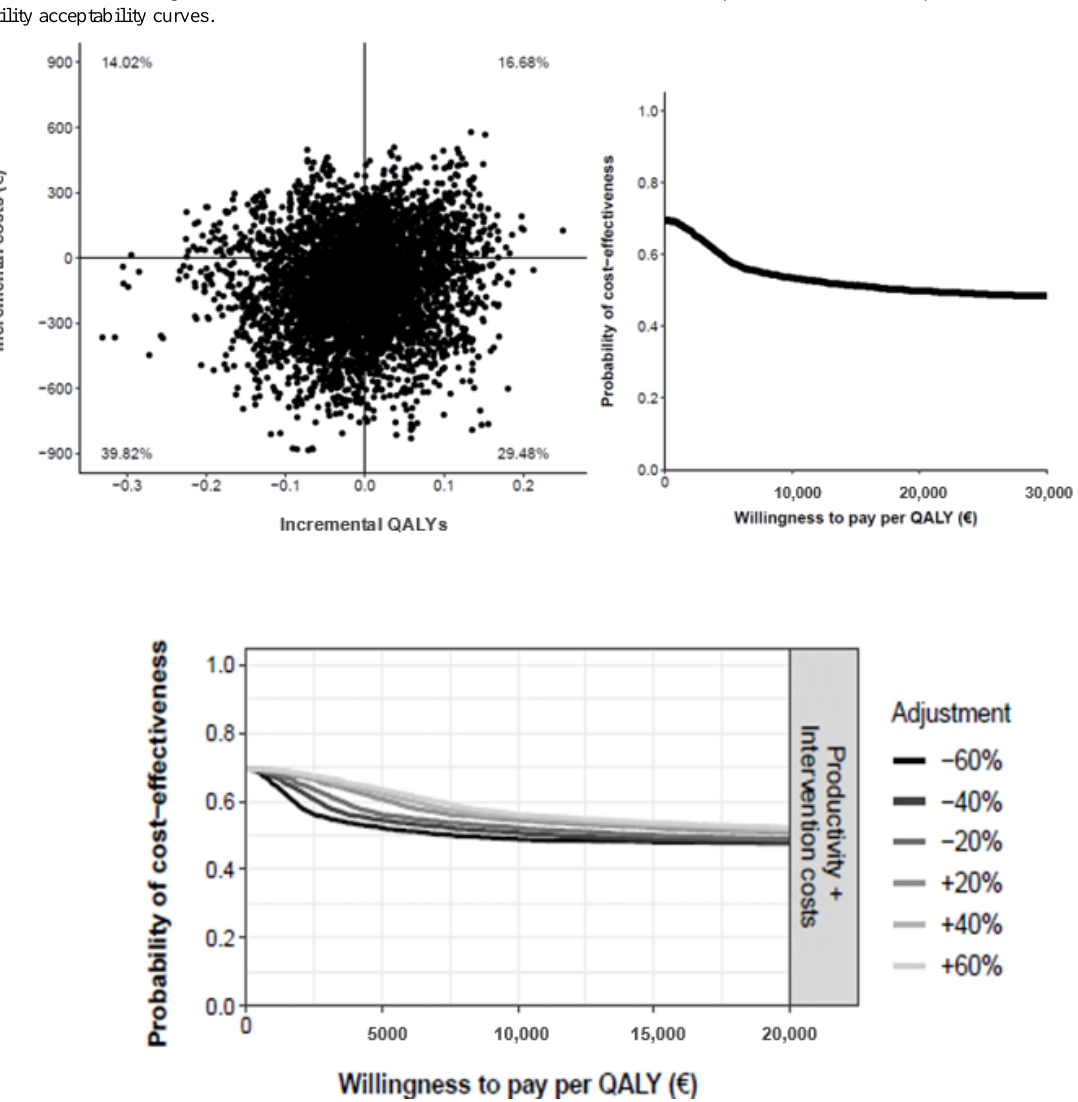
Figure 7. Cost-effectiveness plane (top left) and cost-effectiveness acceptability curve (top right) comparing the effect on quality-adjusted life-years (QALYs) of Telemonitoring of Crohn’s Disease and Ulcerative Colitis (TECCU) versus telephone care. Bottom: impact of different cost values on the cost-utility acceptability